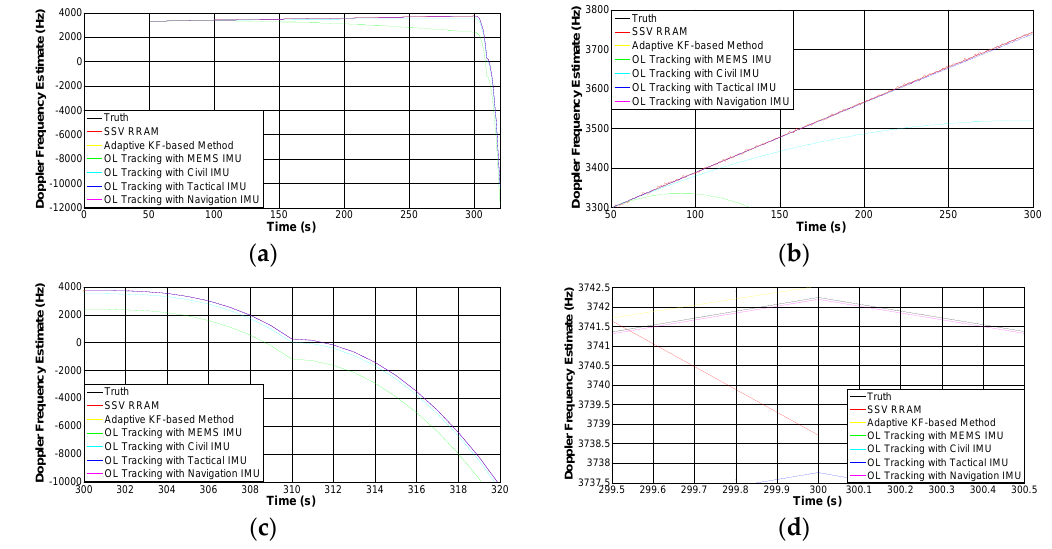
Figure 9. Comparison of the estimated Doppler frequency using different tracking schemes in the experiments. ( a ) Global view; ( b ) viewport of the second phase (non-maneuvering); ( c ) viewport of the third and fourth phase (maneuvering); and ( d ) close-up view around the 300th s.